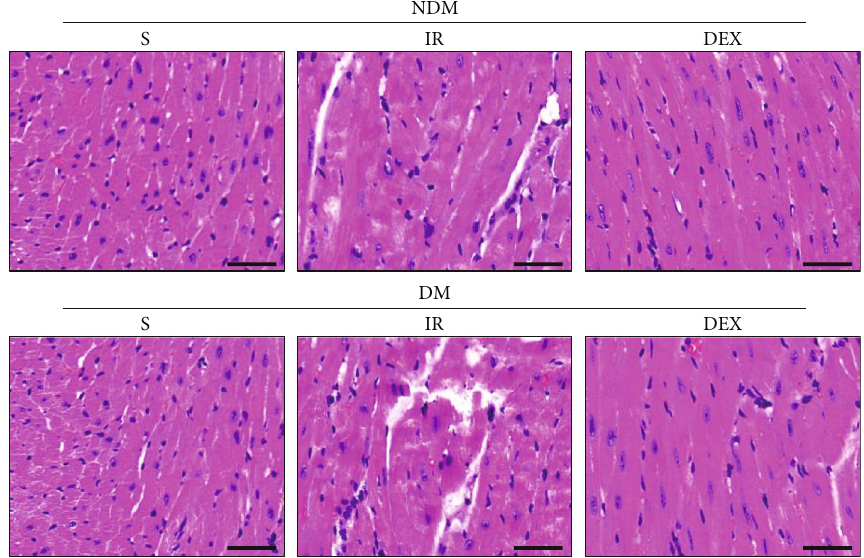
Figure 2: DEX alleviates myocardial tissue damage in rats. The myocardial tissue structure and cell necrosis were observed by HE staining ( scale bar = 50 μ m).